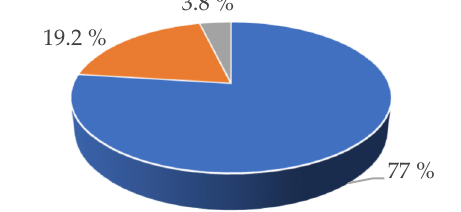
Figure 1. Percentage of answer predisposing to defensive medicine.